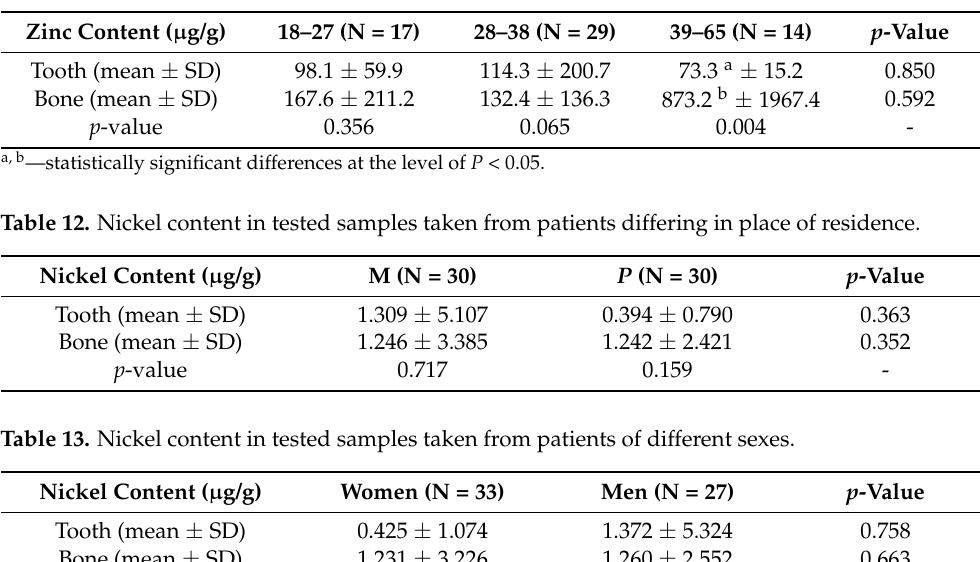
Table 11. Zinc content in tested samples taken from patients of different age.